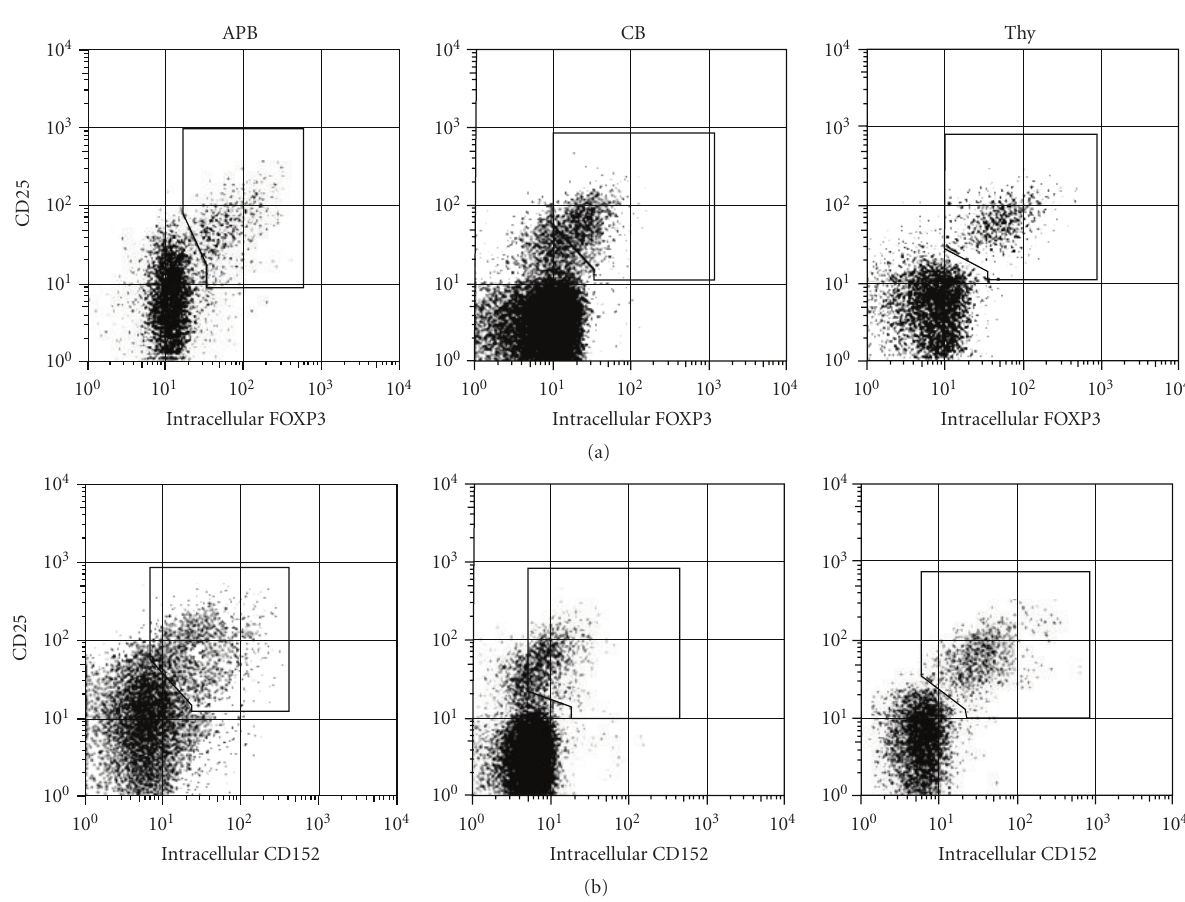
Figure 4: Weak expression of FOXP3 and CD152 proteins in CB CD25 + CD4 + T cells. Mononuclear cells or thymocytes were multistained with anti-CD4, anti-CD8, anti-CD25, anti-CD45RA, anti-FOXP3, and anti-CD152 Abs (Table 1). The profiles were gated for CD8 − CD4 + , and showed expression of CD25 versus endogenous FOXP3 (top panel) or CD152 (bottom panel). Additional gating was set on FOXP3 or CD152 positive cells. Data are representative of 3 di ff erent